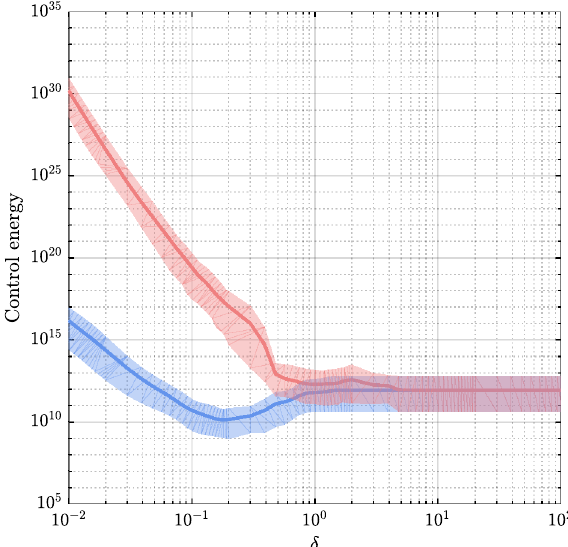
Figure 1. Control energy requirements in the deterministic (blue) and stochastic (red) scenario for the yeast Saccharmoyces cerevisiae . The solid lines are the minimum energies as a function of δ averaged over 10 3 final states x ( t m ) selected on the unit hypersphere centered in the origin. The shaded areas are enclosed by the observed minimum and maximum energies. The minimum energy feedback control strategy is implemented both in the stochastic and in the deterministic scenario. The picture shows that in the stochastic scenario